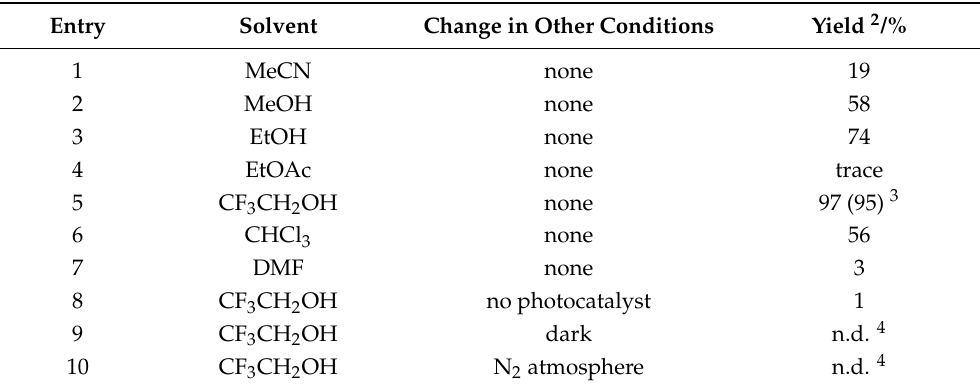
Table 1. Photo-oxidation of thioanisol 1